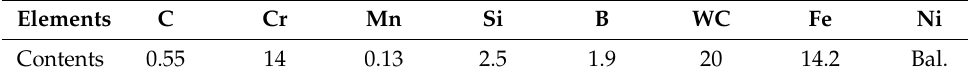
Table 2. Chemical composition of SD-Ni45 powder (wt.